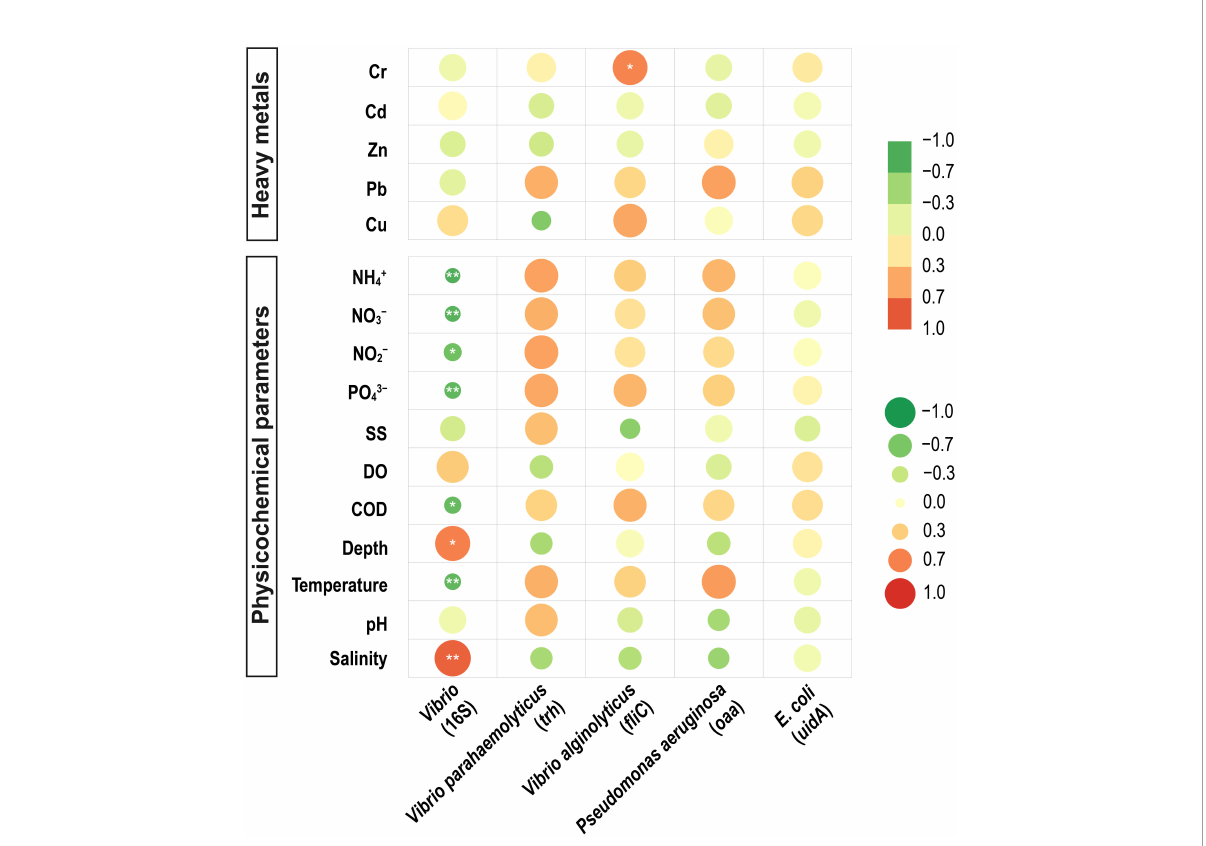
FIGURE 4 Correlation between abundance, maker genes, and environmental factors. Horizontal axes represent the gene abundance ( Vibrio 16S rRNA, V. parahaemolyticus trh , V. alginolyticus fl iC , P. aeruginosa oaa , E. coli uidA ). The vertical axis represents the environmental factors. The circle ’ s color inside the grid indicates a positive or negative Pearson ’ s correlation; the circle ’ s color depth and size denote the correlation ’ s strength. The deeper the red, the higher the positive correlation between the two factors; the deeper the green, the higher the negative correlation. *signi fi cant correlation at 0.05 level, **signi fi cant correlation at 0.01